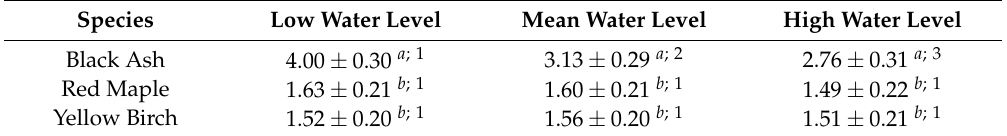
Table 3. Estimated marginal mean sap flux (m 3 m − 2 day − 1 ) and standard error by species and water level